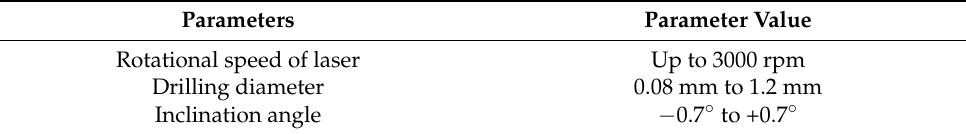
Table 2. Specifications of the spiral drilling apparatus.